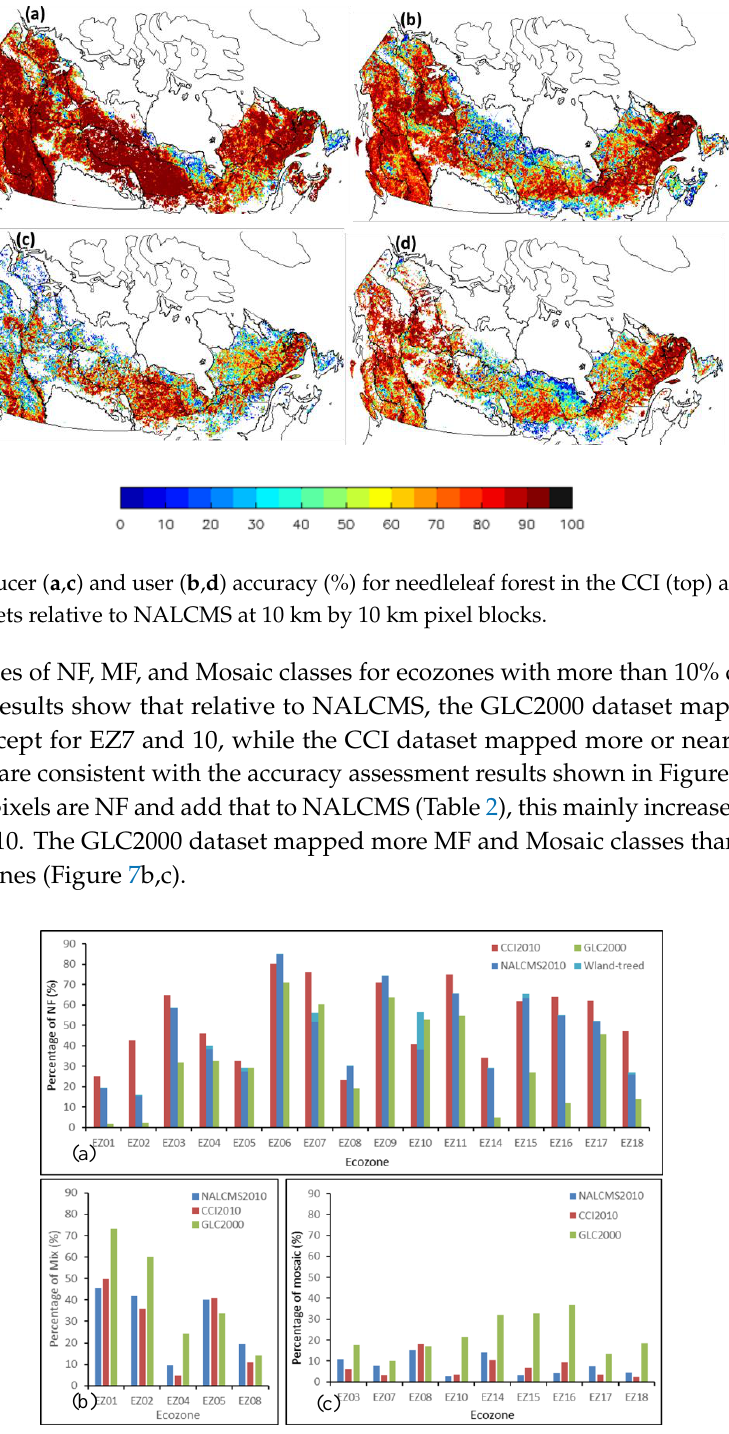
Figure 7. The proportion of needleleaf forest ( a ), mixed forest ( b ) and Mosaic of tree and other vegetation ( c ) in ecozones with greater than 10% cover (at least one dataset) from each datasets.